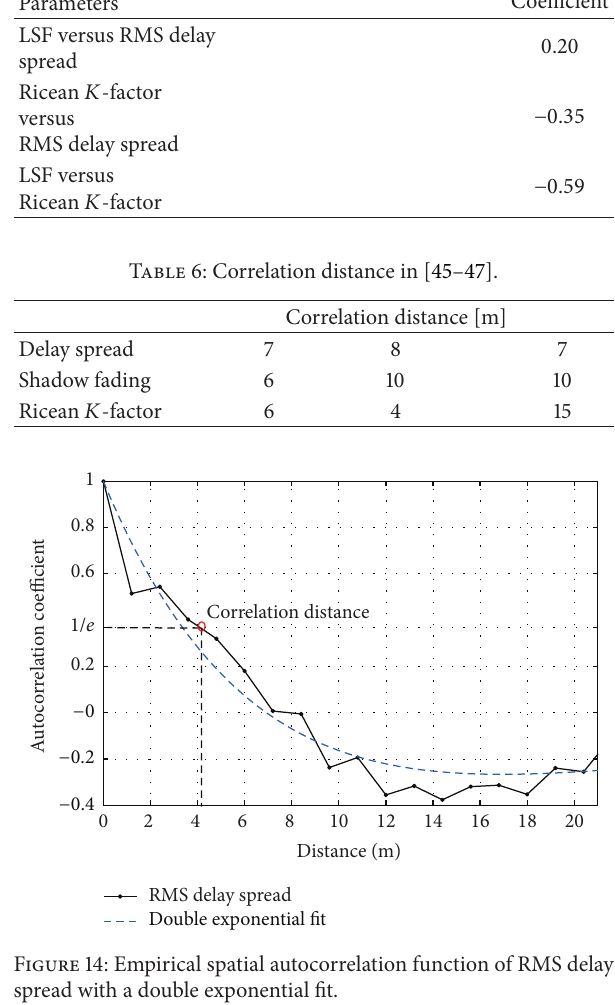
Figure 13: Empirical spatial autocorrelation function of Ricean 𝐾 - factor with a zero-order first kind Bessel fit.